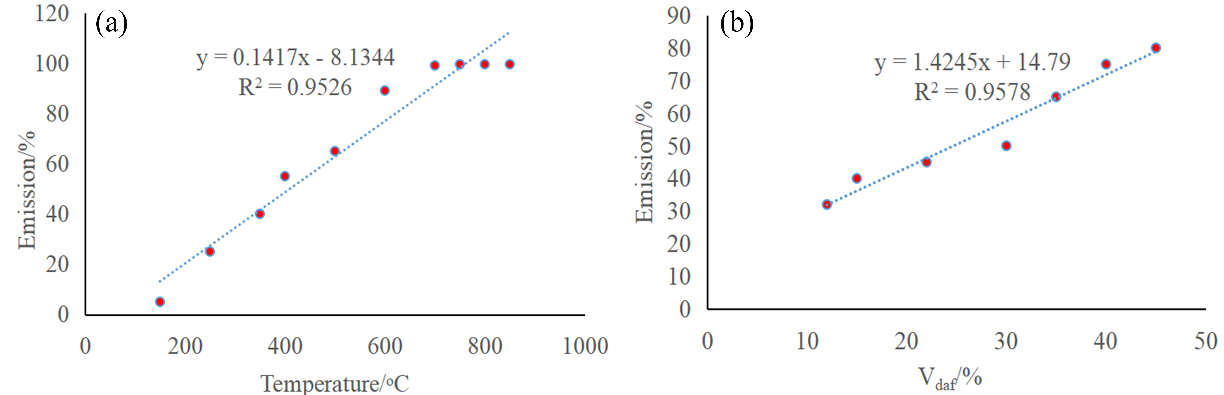
Figure 4. Relation between chlorine emission and ( a ) temperature, ( b ) volatile matter (V daf ) .